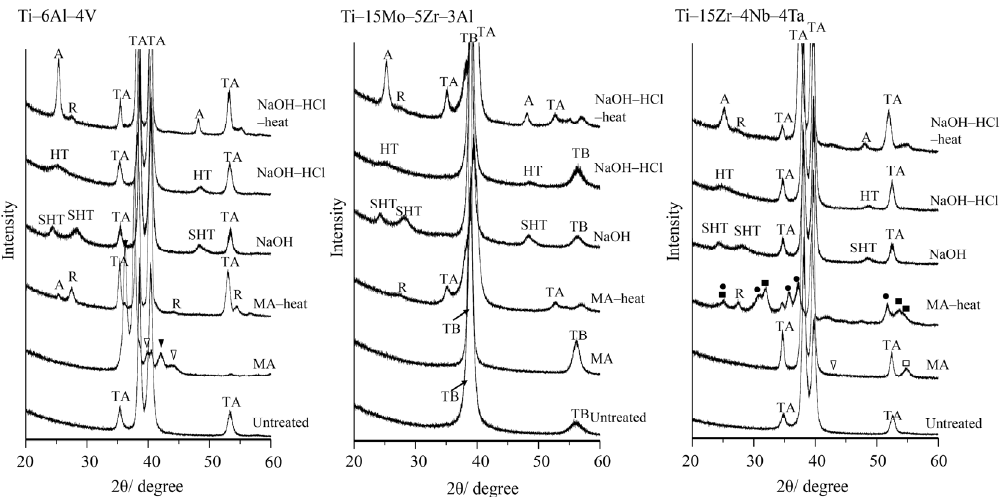
Figure 2. XRD profiles of the surfaces of Ti alloys untreated and subjected to mixed-acid and heat treatments or NaOH, HCl and heat treatments. TA: α -Ti, TB: β -Ti, A: Anatase. (cid:72) : TiH 0.71 , (cid:79) : TiH,